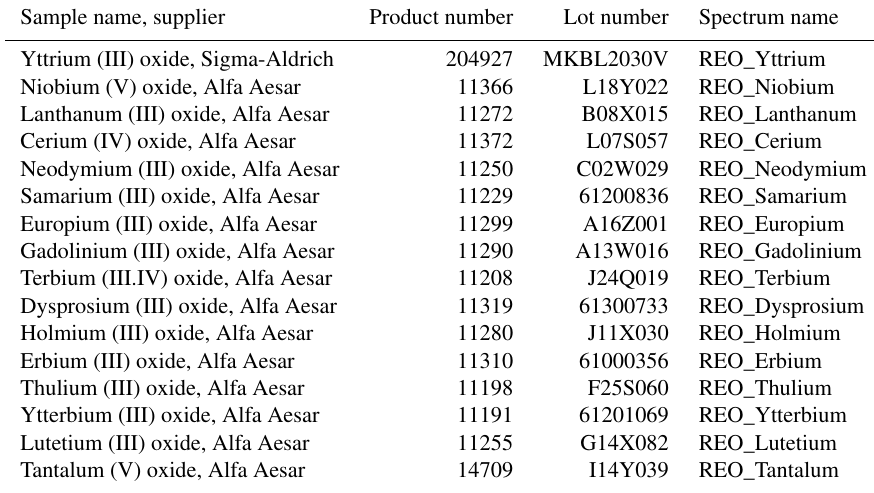
Table 9. Sample name and supplier, product and lot number, and spectral library filenames of the rare-earth oxide